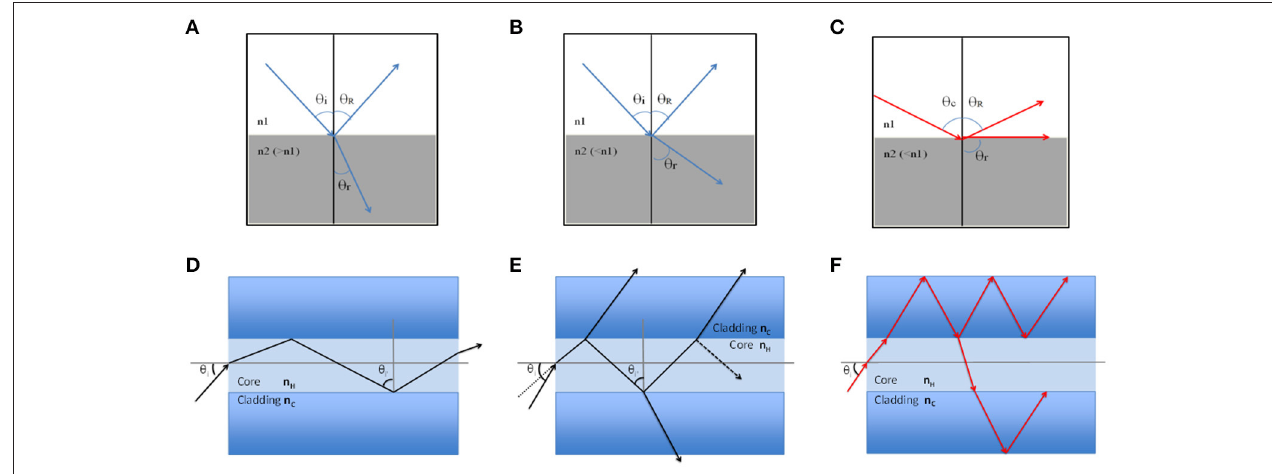
FIGURE 1 | Schematic representation of light reflection and guiding. (A) Schematic light refraction between two different media with θ i < θ c and n 2 > n 1 ; (B) Light refraction with θ i < θ c and n 2 < n 1 ; (C) Total light reflection with θ i ≥ θ c that indicates the evanescent field; (D) Light in-coupling at one fiber end with θ i > θ c . It propagates without losses all along the fiber; (E) Light in-coupling with θ i < θ c . Part of the wave penetrates the cladding and can escape in the outer medium;